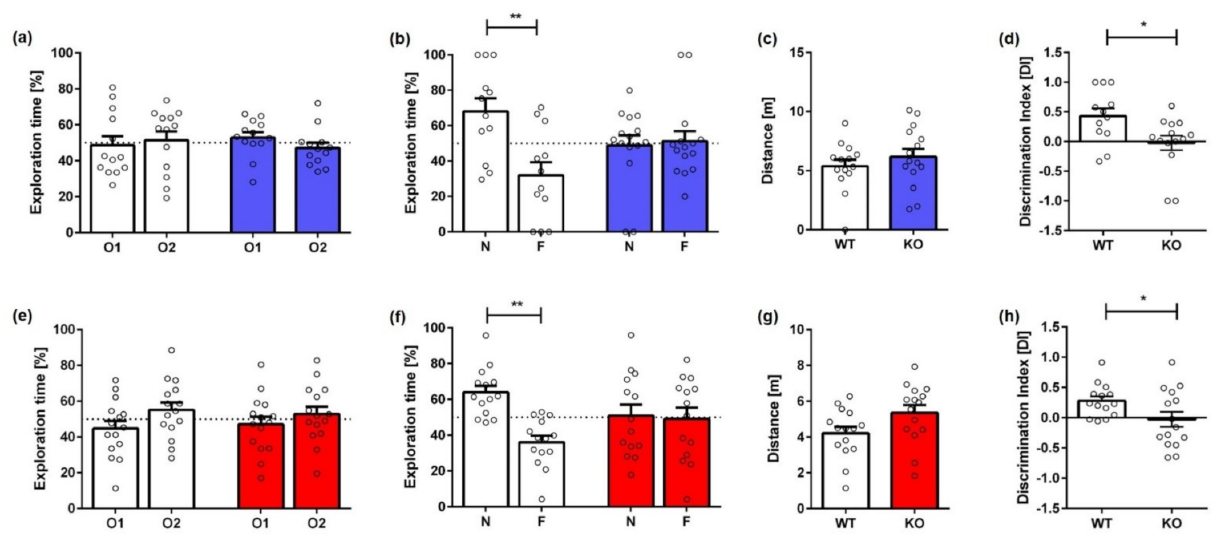
Figure 1. Recognition memory deficits of Mover KO mice in the novel object recognition task. During the training phase, all male ( a ) and female ( e ) mice spent equal amounts of time with two similar objects (O1, O2). During the testing phase, only male ( b ) and female WT animals ( f ) showed a significant preference for the novel object (N). In contrast, Mover KO mice did not discriminate between the novel (N) and the familiar object (F). Distance traveled did not differ between male ( c ) or female KO ( g ) and WT animals. Calculation of the discrimination index (DI) also revealed recognition memory deficits in male ( d ) and female KO mice ( h ). Fifty percent chance level is indicated by a dashed line. Paired t -test ( a , b , e , f ) and unpaired t -test ( c , d , g , h ); n = 15–17. Data presented as mean ± S.E.M. * p < 0.05; ** p <